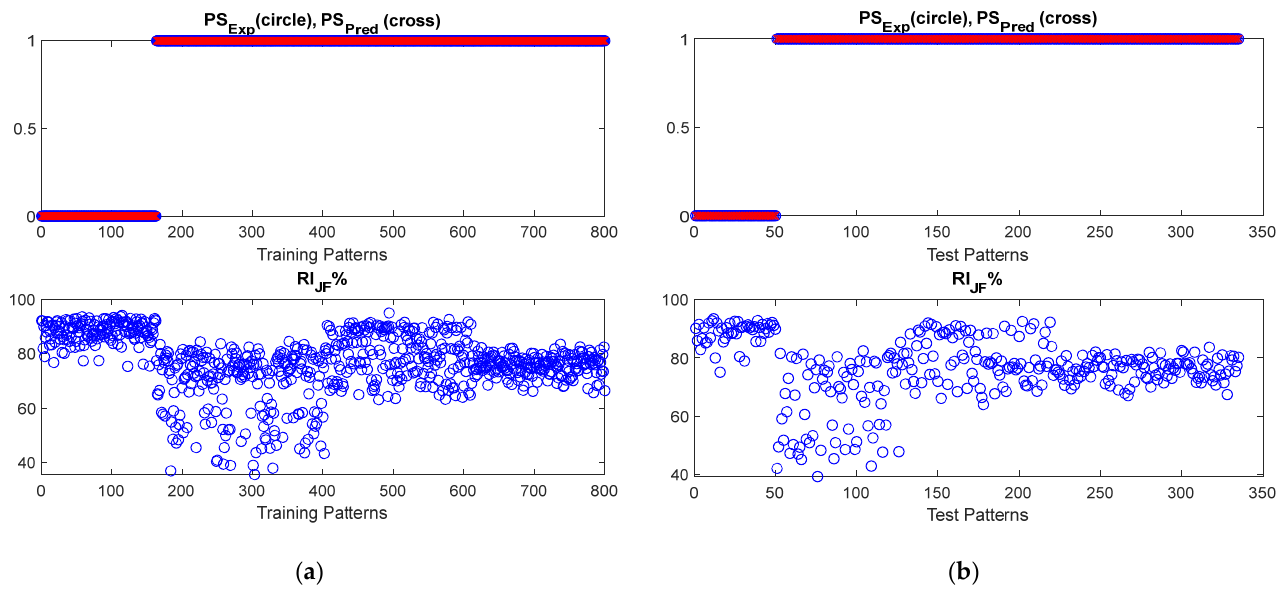
Figure 4. The behavior of the threshold-based algorithm for postural status detection. Both ( a ) training and ( b ) test datasets are shown.